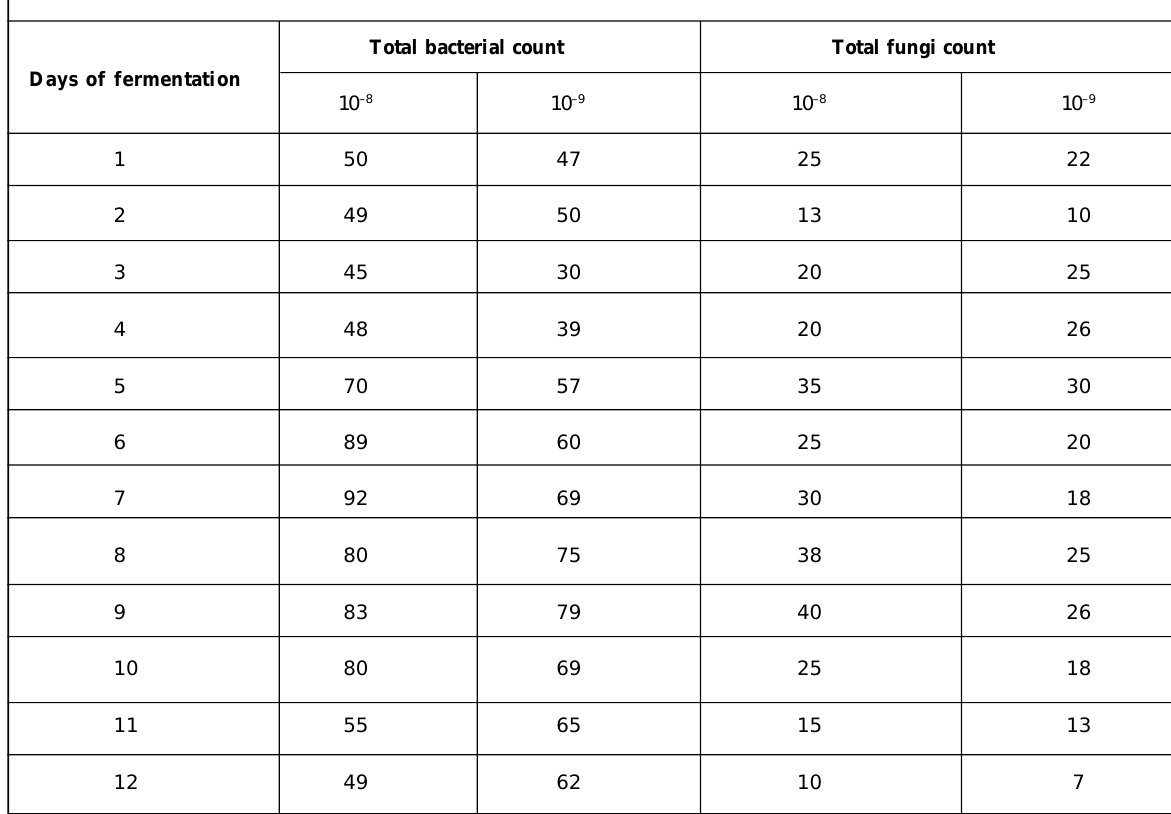
Table 1: Aerobic microbial counts (CFU/ml) of rumen substrate Total bacterial Days of fermentation